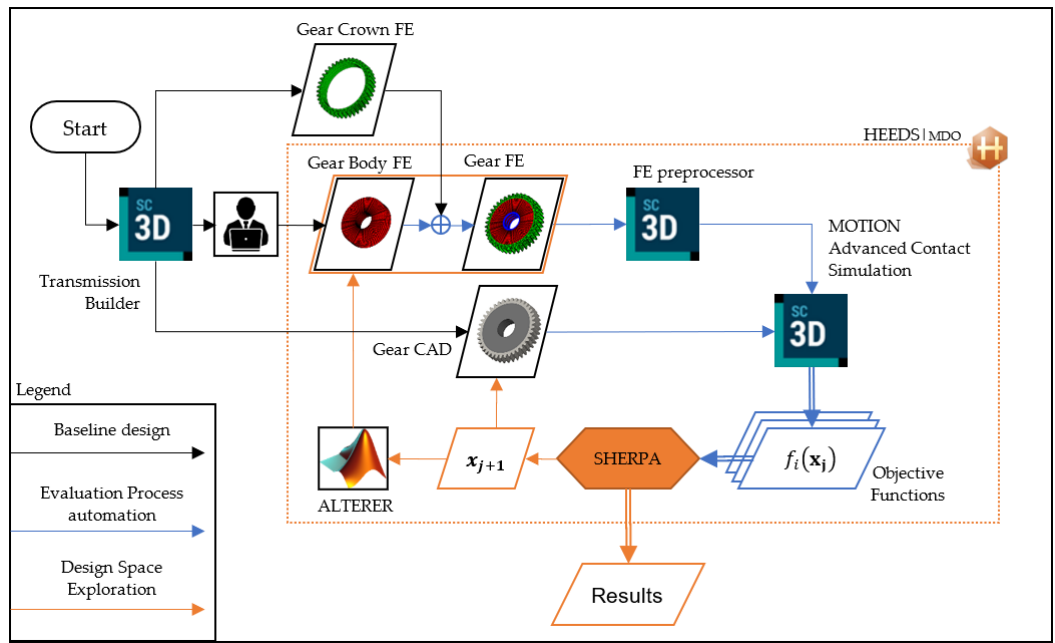
Figure 5. Multiobjective lightweight design: flowchart.